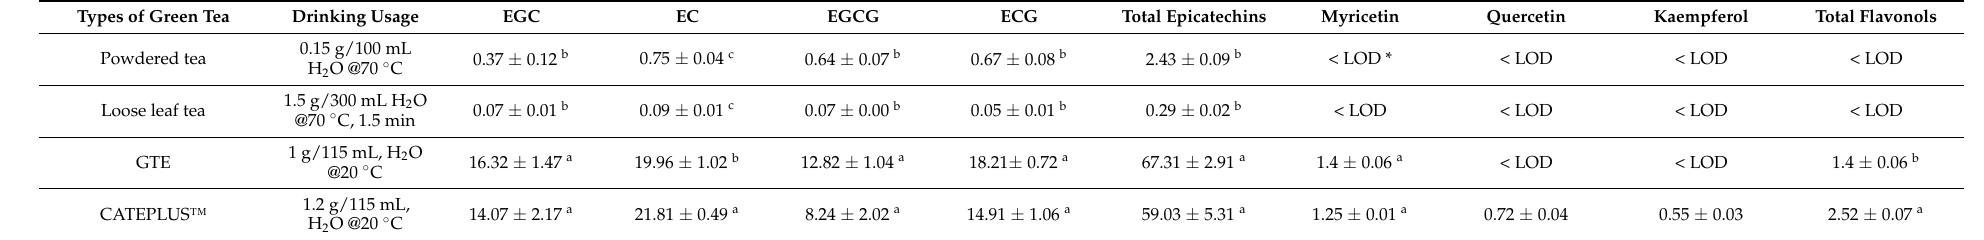
Table 3. Contents of epicatechins and flavonols in aqueous fraction from digesta after in vitro digestion (mg/g dry weight).